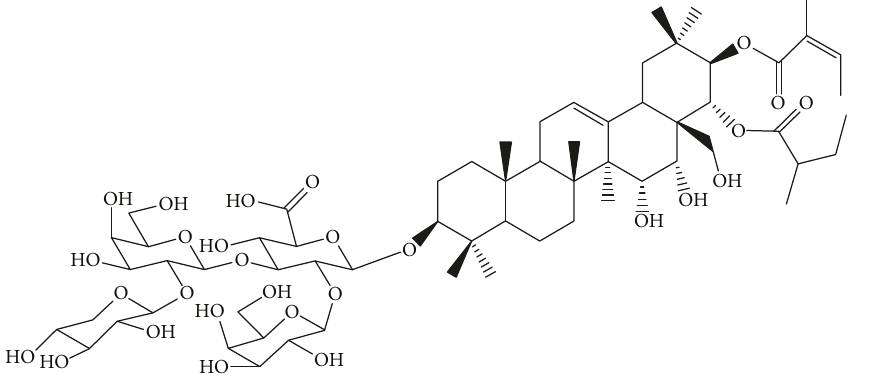
Figure 1: Molecular structure of saponins of Camellia oleifera.